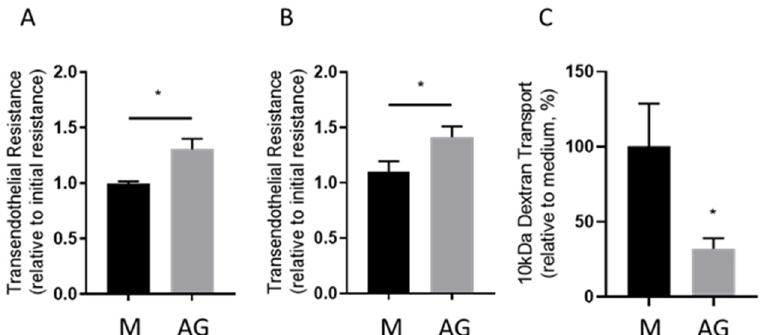
Figure 1. Functional endothelial cell monolayer characterization under the influence of 24 mM AlaGln (AG). The transendothelial resistance (TER) was measured at one ( A ) and five ( B ) hours of AlaGln incubation. FITC-dextran (10 kDa) was introduced apically at time 1 h post AG incubation and its transport to the basolateral compartment was measured after 5 h ( C ). Incubation with 24 mM AG resulted in increase of TER after 1 and 5 h, while the 10 kDa FITC dextran transport was reduced. M = control medium. Data are presented as mean ± SD, n ≥ 6, * p < 0.05.